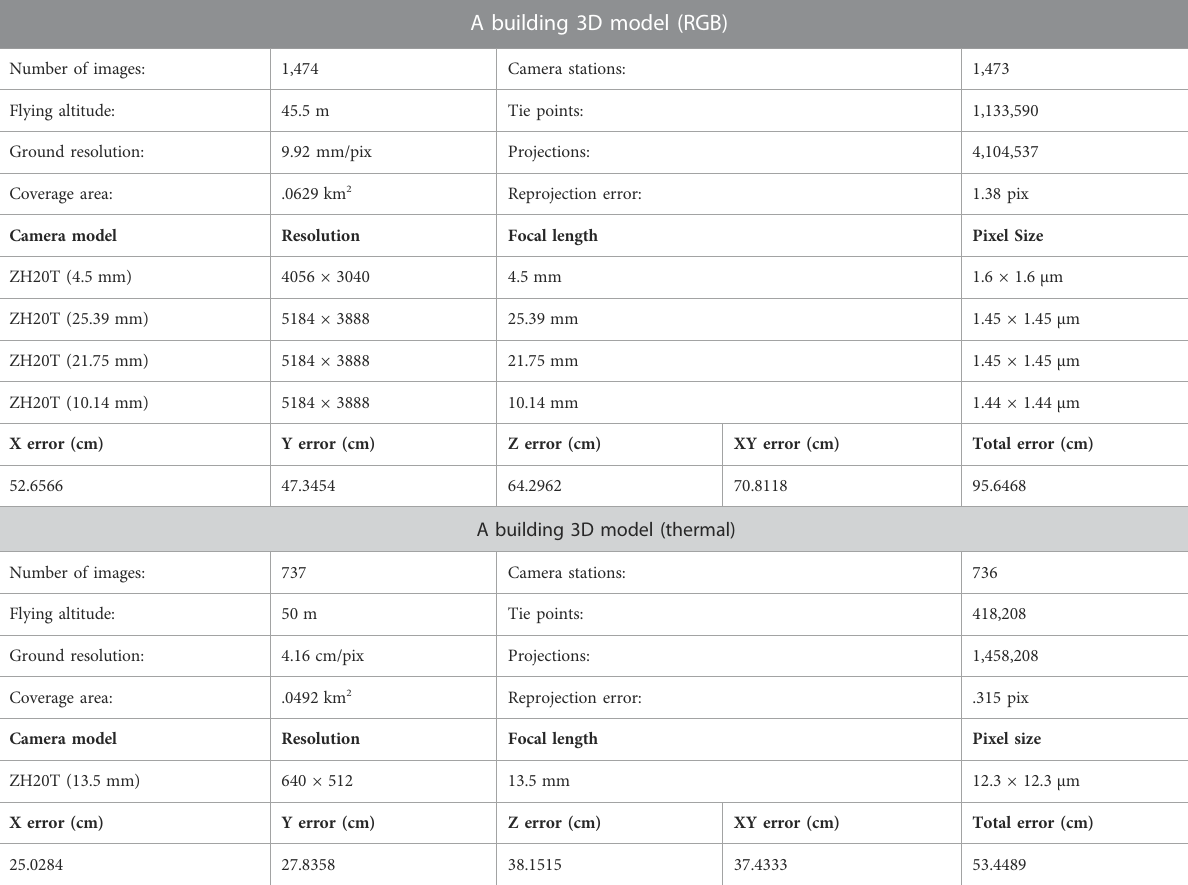
TABLE 3 A building 3D model (RGB, Thermal): Cameras ’ speci fi cations and average camera location error. A building 3D model